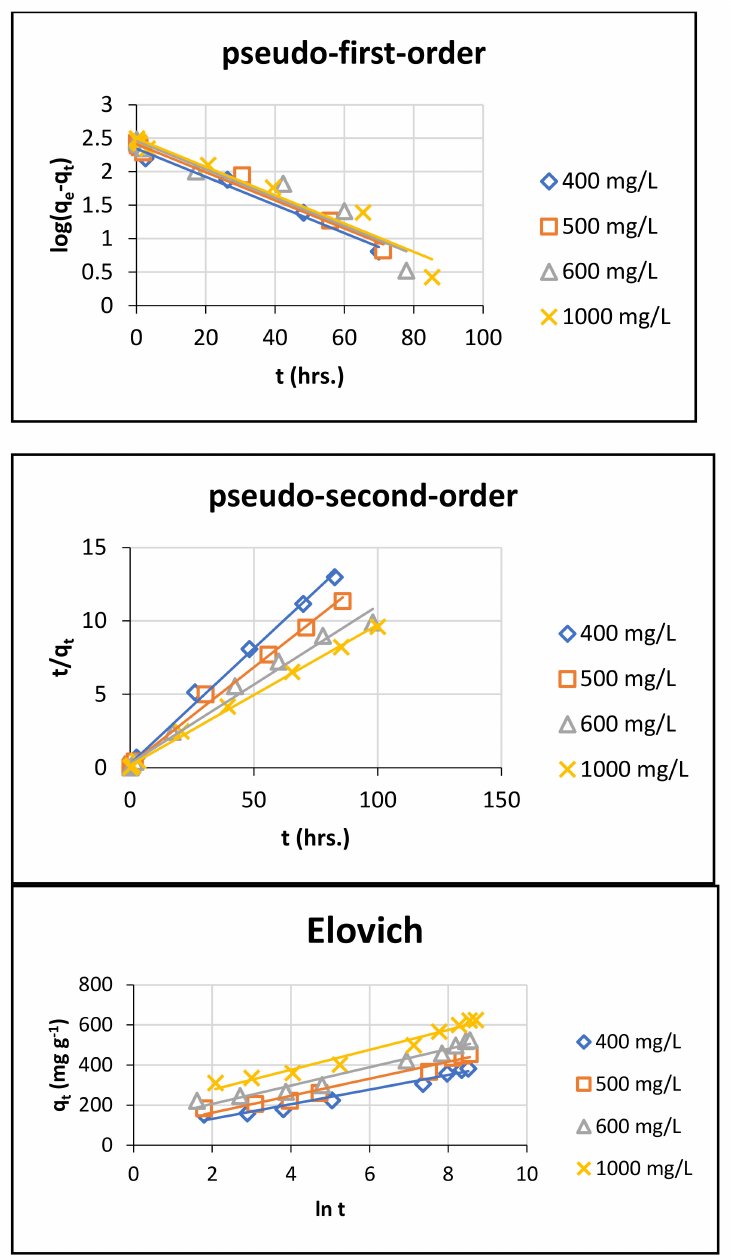
Figure 10. Linear regressions of kinetic plots for the adsorption of CR dye onto UCs (Experimental conditions: 50 mg of adsorbent, 50 mL of dye solution, temperature 55 ◦ C and pH